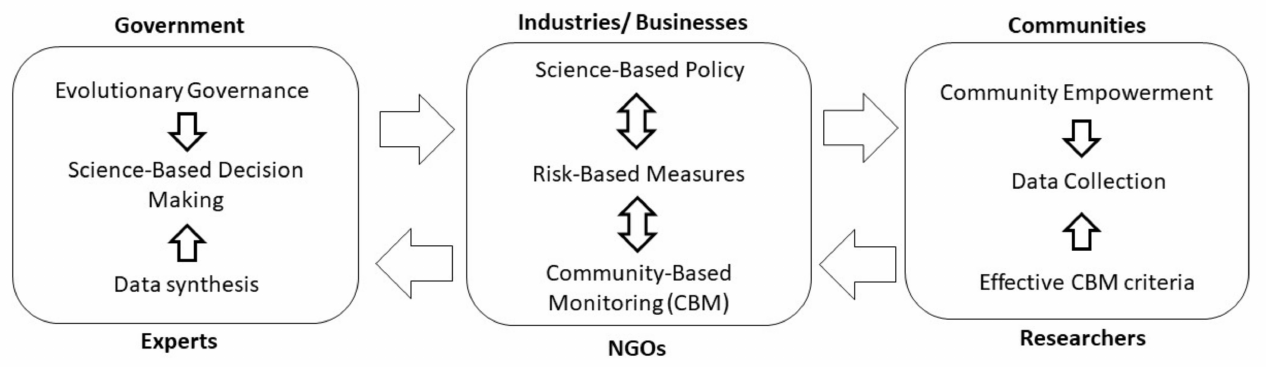
Figure 2. The conceptual approach of evolutionary governance amid COVID-19